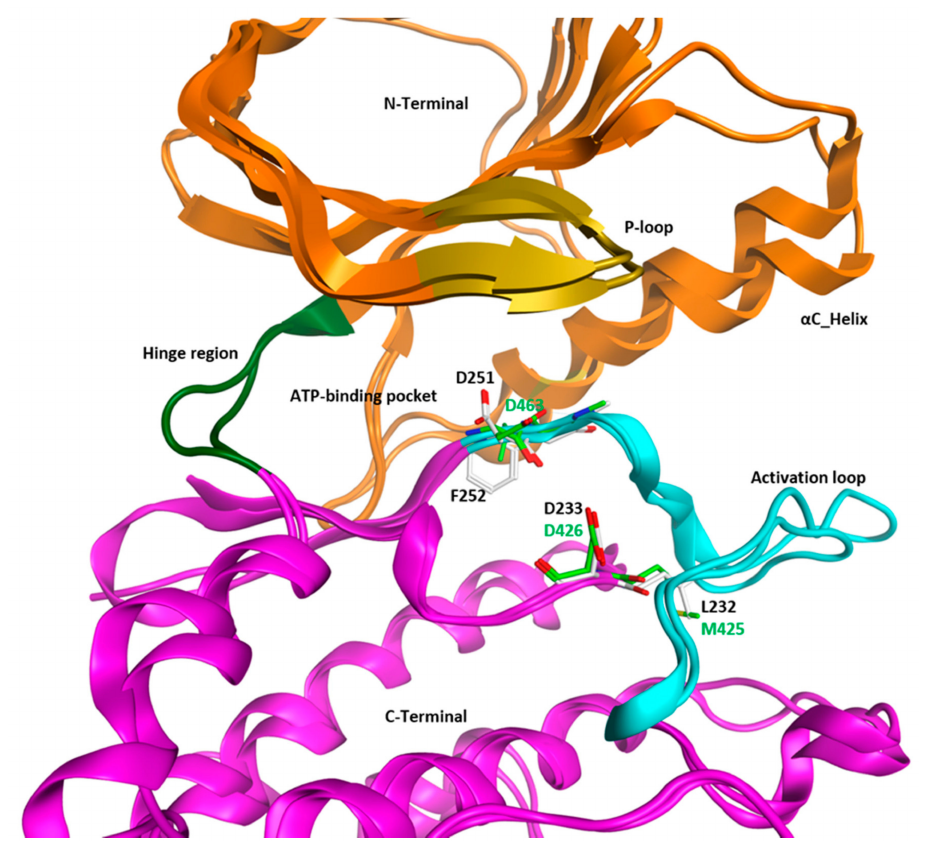
Figure 2. Superposition of crystal structures from the Protein Data Bank (PDB) of WEE1 (PDB ID: 1X8B) and PKMYT1 (PDB ID: 3P1A). The protein ribbon is colored as following: N -Terminus: gold; C -Terminus: magenta; hinge region: dark green; activation loop: cyan; P-loop: yellow; PKMYT1 residues: white; WEE1 residues: